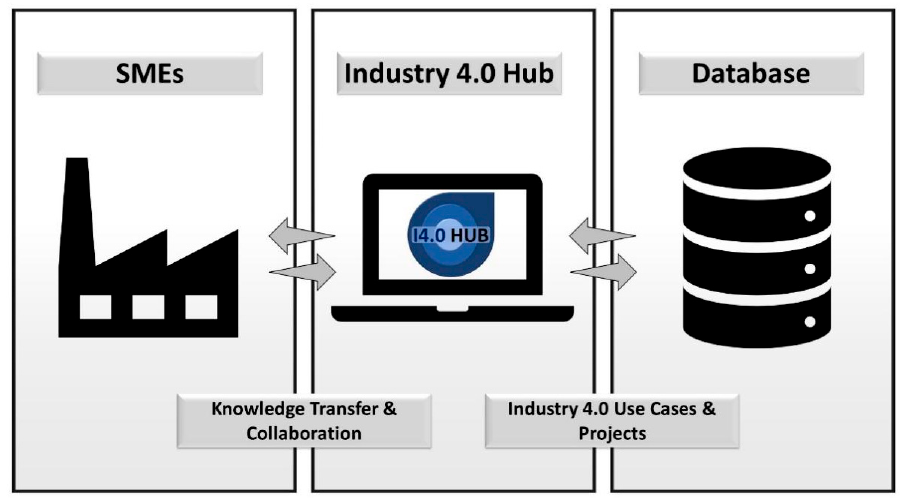
Figure 7. Industry 4.0 HUB architecture.